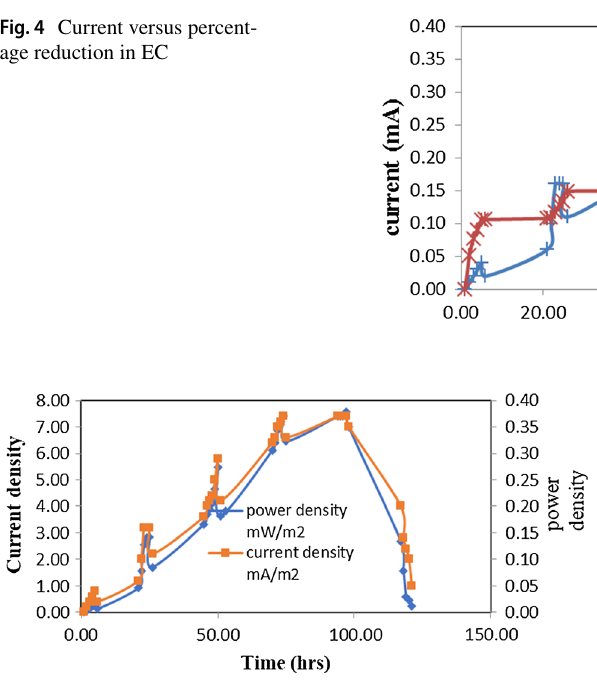
Fig. 5 Current density versus power density Table 6 Performance of EBCR in removing BOD from Sample II Sl. no.